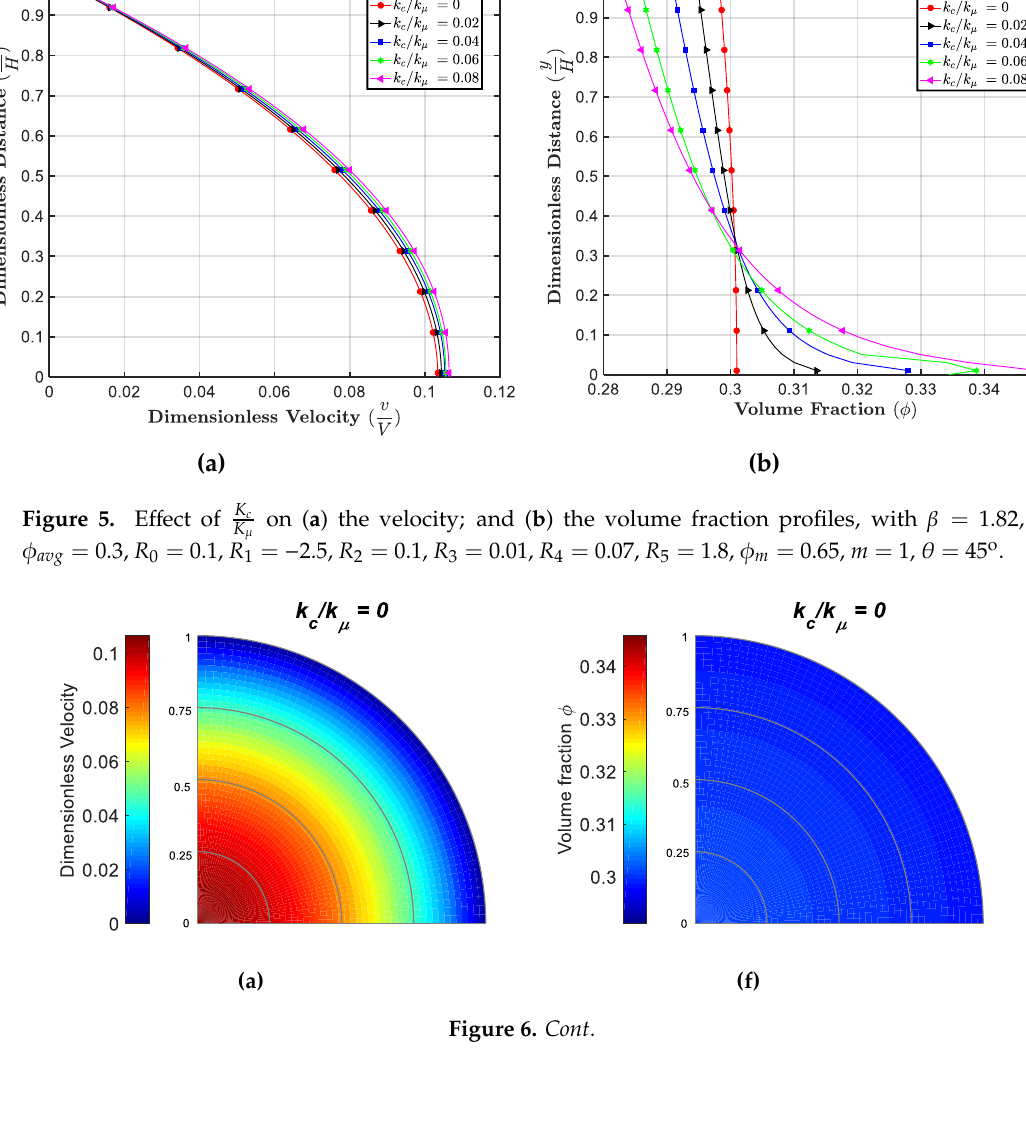
= 0.45 ; ( b ) ϕ = 0.50; ( c ) ϕ = 0.55; ( d ) ϕ = 0.60 ; ( e ) 𝑚 𝑚 𝑚 𝑚 = 0.45 ; ( g ) ϕ = 0.50; ( h ) ϕ = 0.55; ( i ) ϕ = 𝑚 𝑚 𝑚 𝑚